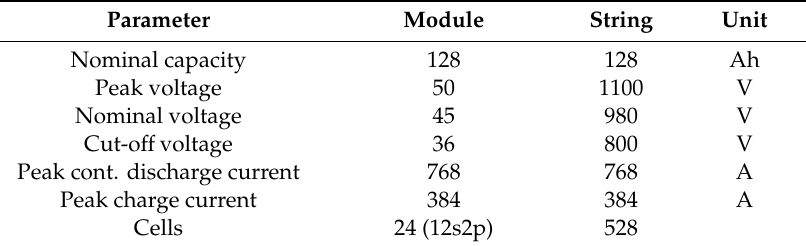
Table 1. Battery module and string specification.